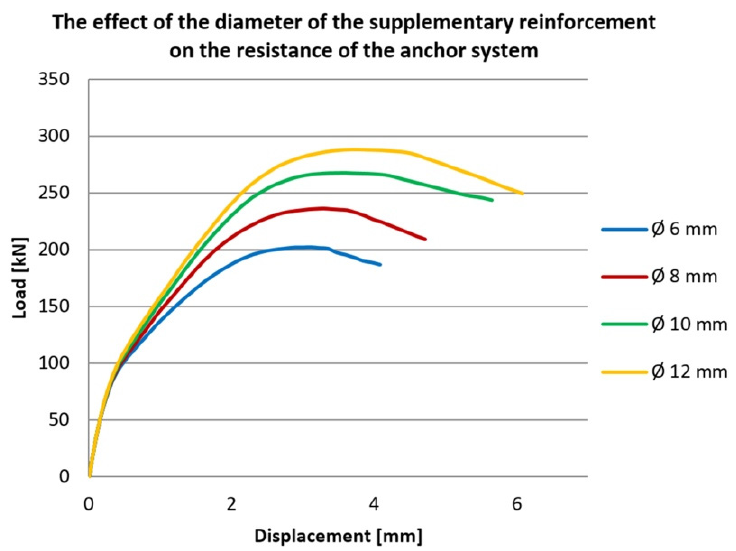
Figure 21. The effect of the supplementary reinforcement diameter on the resistance of the anchor- age system.